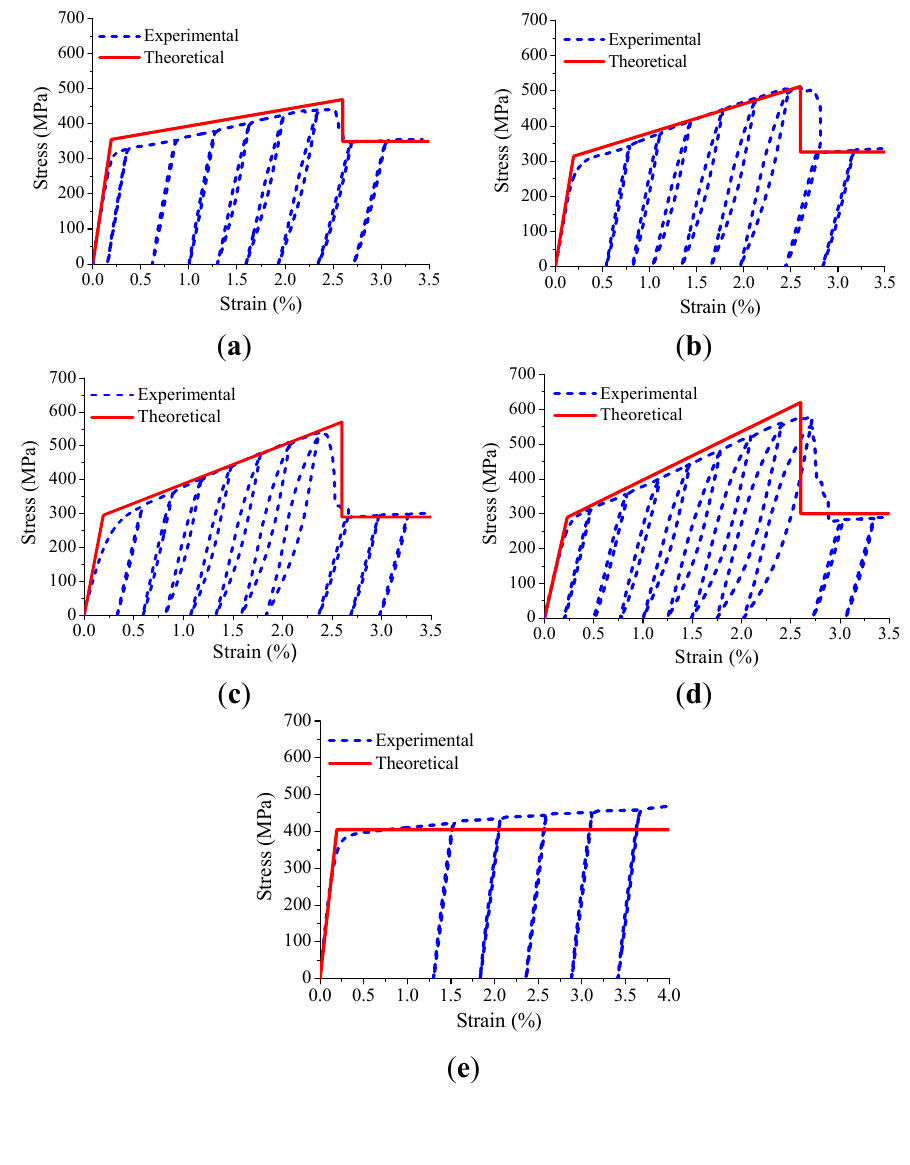
Figure 11. Stress-strain curves of BSP specimens under cyclic tensile loading: ( a ) BSP2; ( b ) BSP4; ( c ) BSP6; ( d ) BSP8; and ( e )